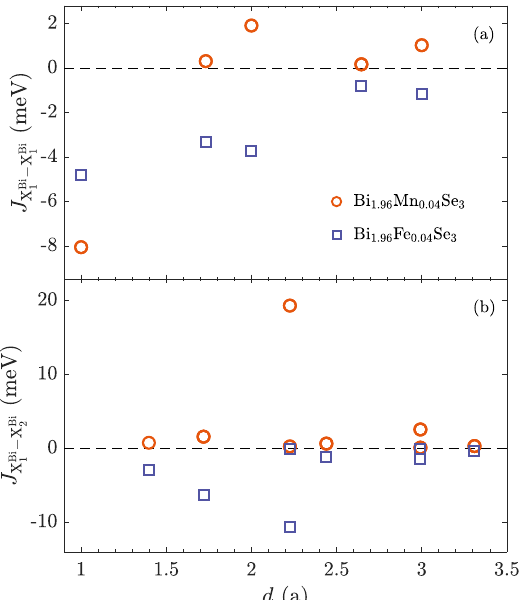
Figure 7. Exchange interactions between magnetic atoms at the substitution position within Bi 2 Se 3 as a function of the distance in units of the lattice parameter a . Multilayered structures composed of 20 QLs and FM ordering are employed. Exchange interactions at central QLs are evaluated. ( a ) Exchange interaction within the same sublattice. Interactions within the atomic layer are depicted. ( b ) Exchange interaction between atoms occupying different sublattices. Interactions across the vdW gap are depicted